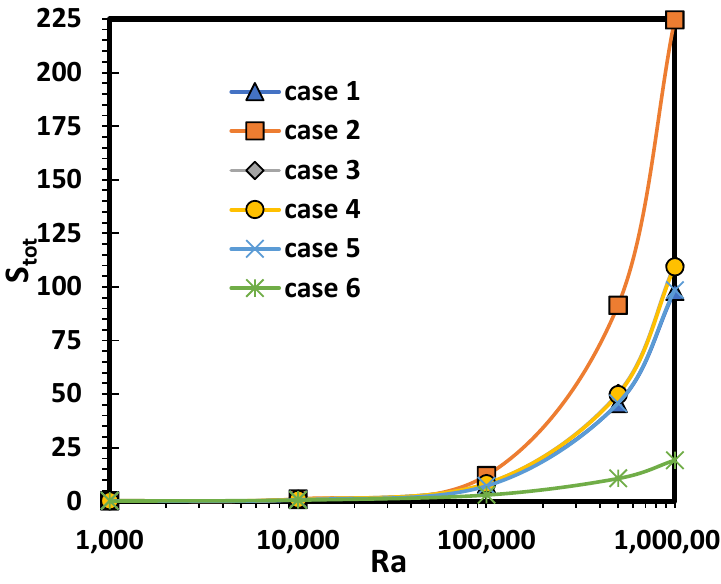
Figure 15. Total entropy generation for various heat source positions and different Ra.